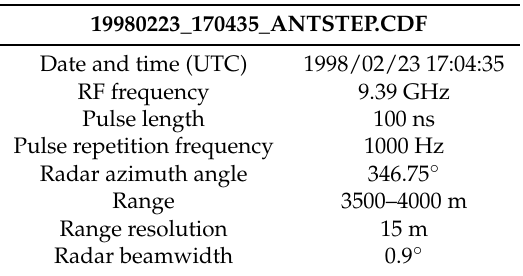
Table 2. The system parameters of the IPIX radar sensor.